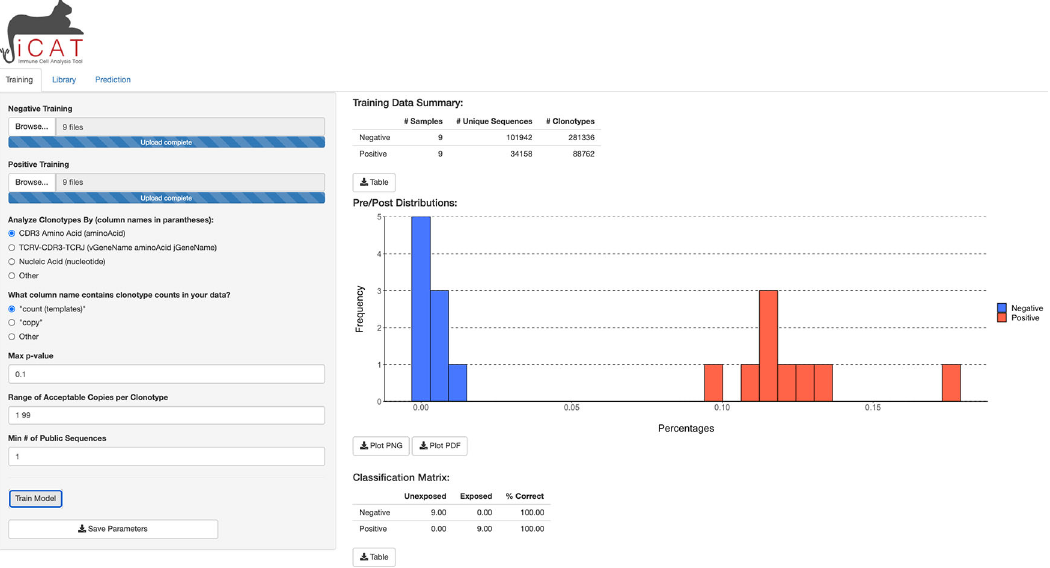
Figure 2. iCAT Training tab. After samples are uploaded, clicking “ Training ” will start training to select features for the diagnostic classifier from the negative and positive